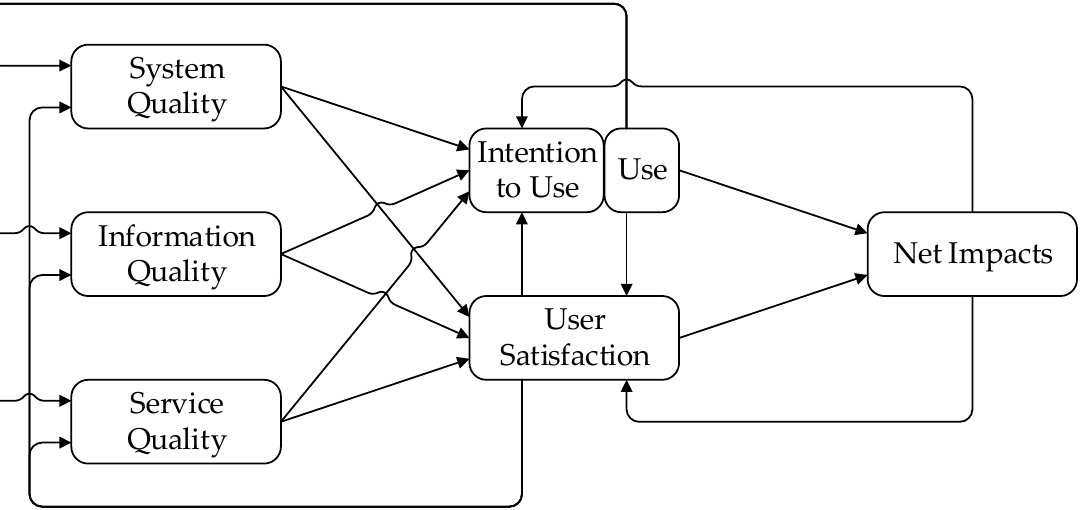
Figure 1. DeLone and McLean IS Success model (version 3). Adapted from DeLone and McLean [22].